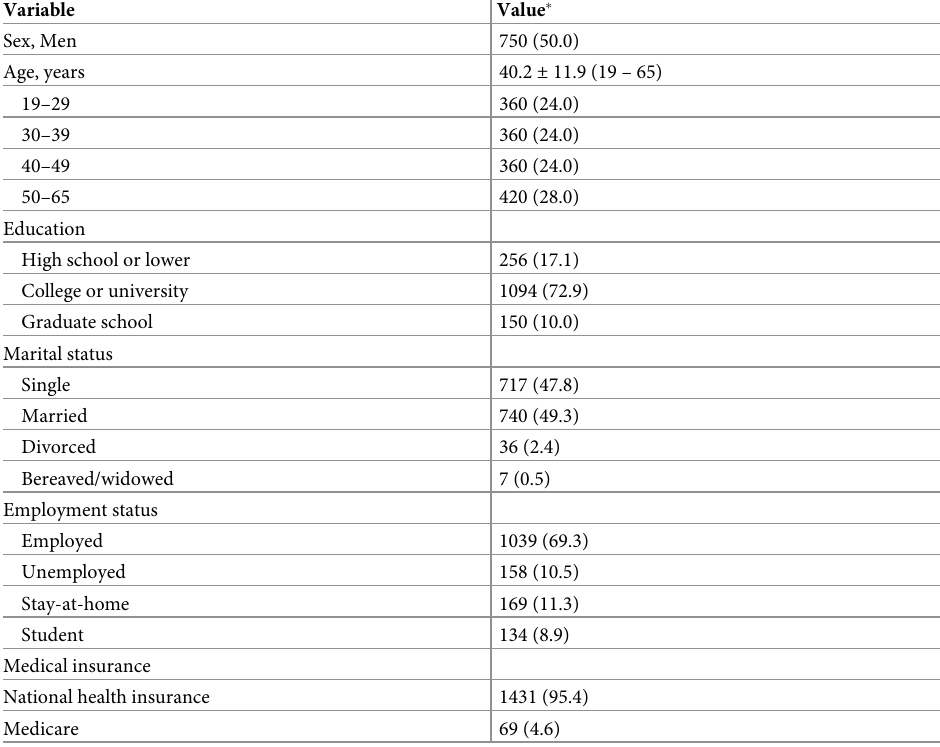
Table 2. Demographic characteristics of the study